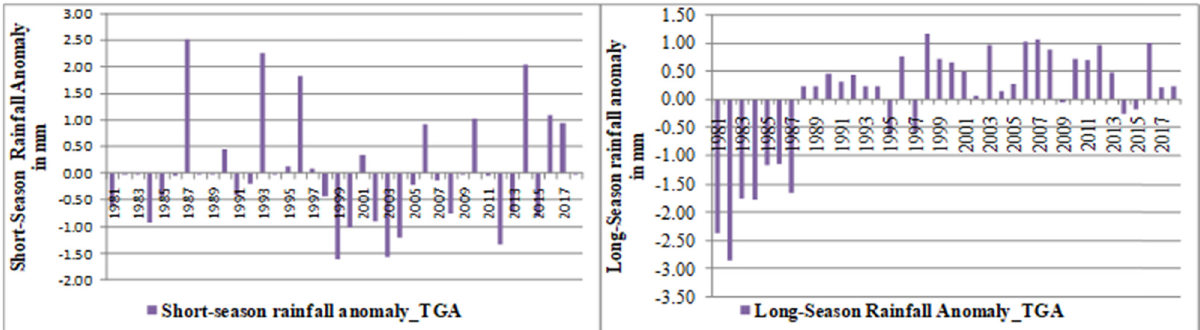
Figure 6: Short - and Long - season rainfall anomaly in te ff growing areas, 1981 – 2018.